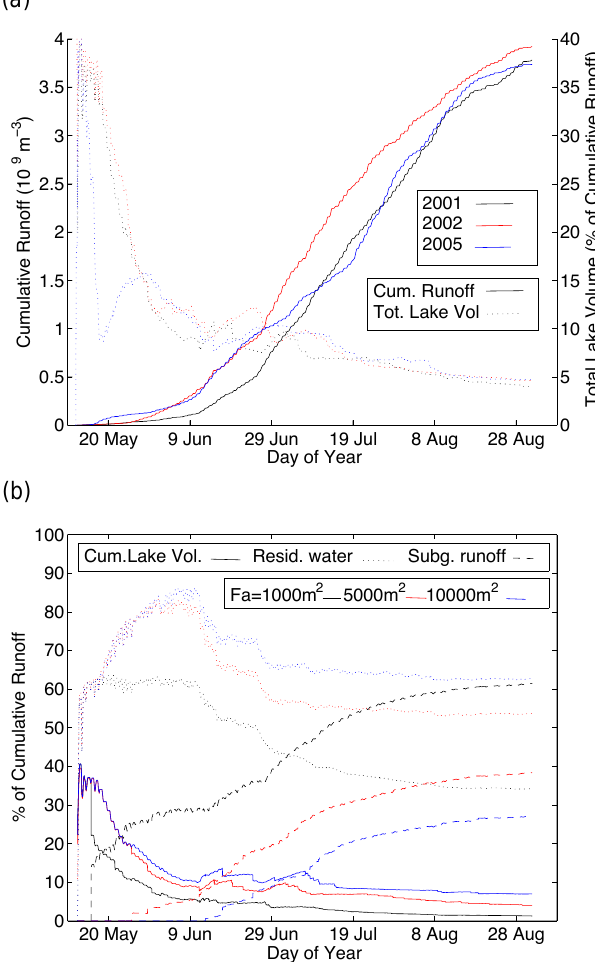
Figure 2. (a) Modelled evolution of total water storage (as a pro- portion of total runoff) in lakes in comparison with total modelled runoff for the three years discussed in the text, for F a = 5000m 2 . (b) Cumulative lake volume (Cum. Lake Vol.), the cumulative amount of residual water (see text) (Resid. water), and the cumu- lative amount of runoff which enters the subglacial drainage system via drained lakes (Subg. runoff), all as proportions of total cumula- tive runoff for 2001, for F a = 1000m 2 ; 5000m 2 and 10000m 2 .